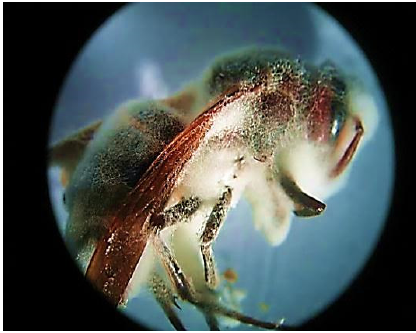
Figure 1. Stereo image of fungal infected Vespa orientalis wasp (2.5 × ).